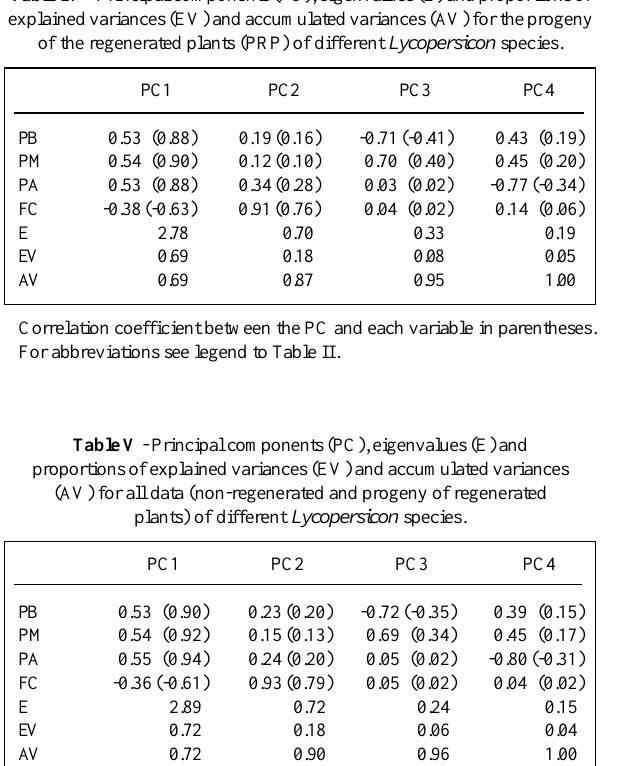
Table IV - Principal components (PC), eigenvalues (E) and proportions of explained variances (EV) and accumulated variances (AV) for the progeny of the regenerated plants (PRP) of different Lycopersicon species.